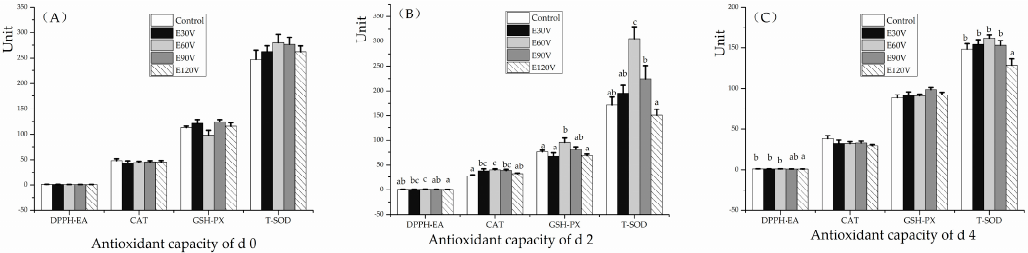
Figure 1. Effect of electrical stunning (ES) methods on the antioxidant capacity of meat goose livers at 0 to 4 days postmortem. Figures ( A–C ) respectively represent the antioxidant capacity of livers that were stored at 4 °C for 0, 2, and 4 days. Geese were slaughtered without stunning (the control) or after ES for 10 s with alternating current (AC) at 500 Hz in a water bath which combined either with 30 V/20 mA (E30V), 60 V/40 mA (E60V), 90 V/70 mA (E90V), or with 120 V/100 mA (E120V).